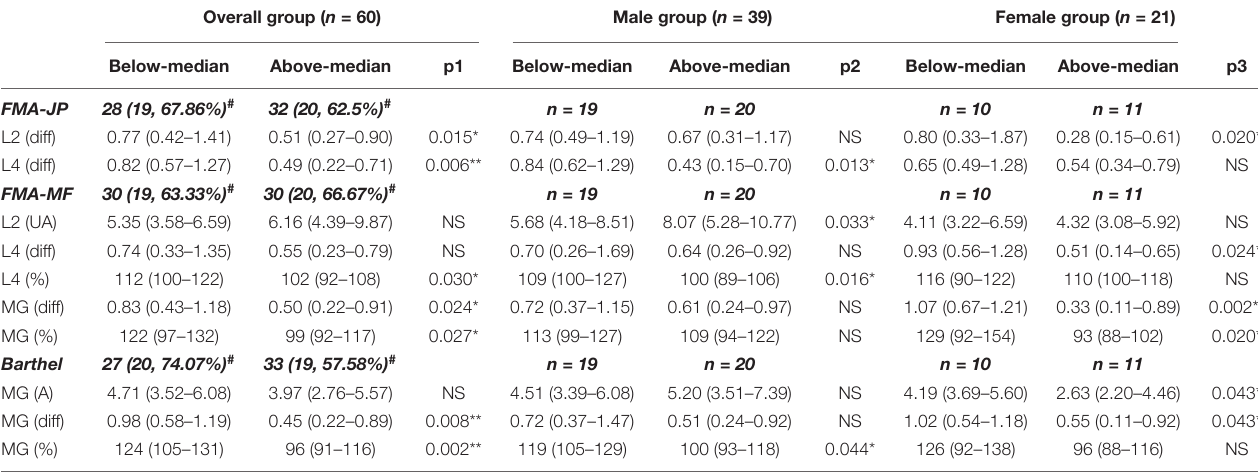
TABLE 4 | All significant between-group differences based on the medians of the assessment scales (kgf or%). Overall group ( n = 60) Male group ( n = 39) Female group ( n = 21) Below-median Above-median p1 Below-median Above-median p2 Below-median Above-median